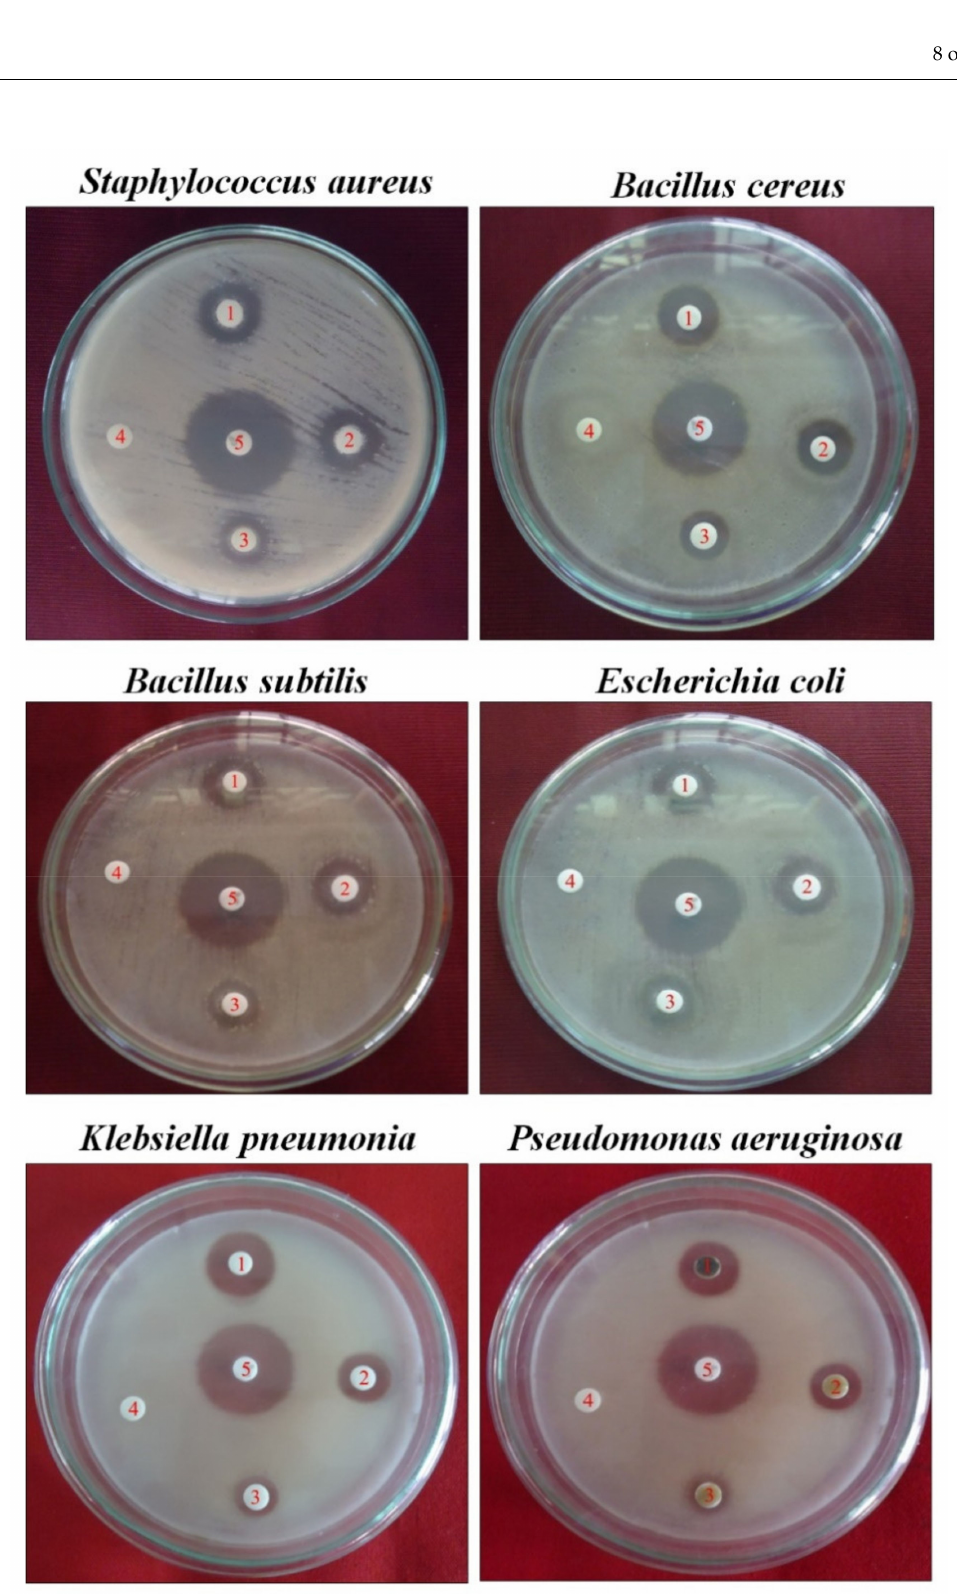
Figure 2. Antiseptic activity is indicated as a zone of inhibition by MeOH leaf extract of Azima tetracantha Lam. Numbers in the Petri dish are as follow: (1) 500, (2) 125, (3) 50 µ g/disc, (4) negative control DMSO, and (5) positive control